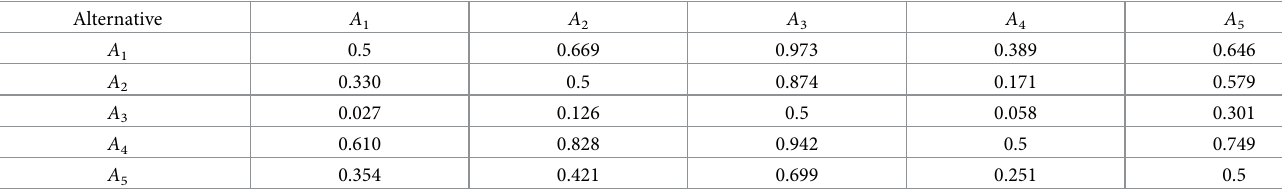
Table 4. Alternatives’ evaluation with respect to Definition 2 and Remark 1, a fuzzy preference matrix. Alternative